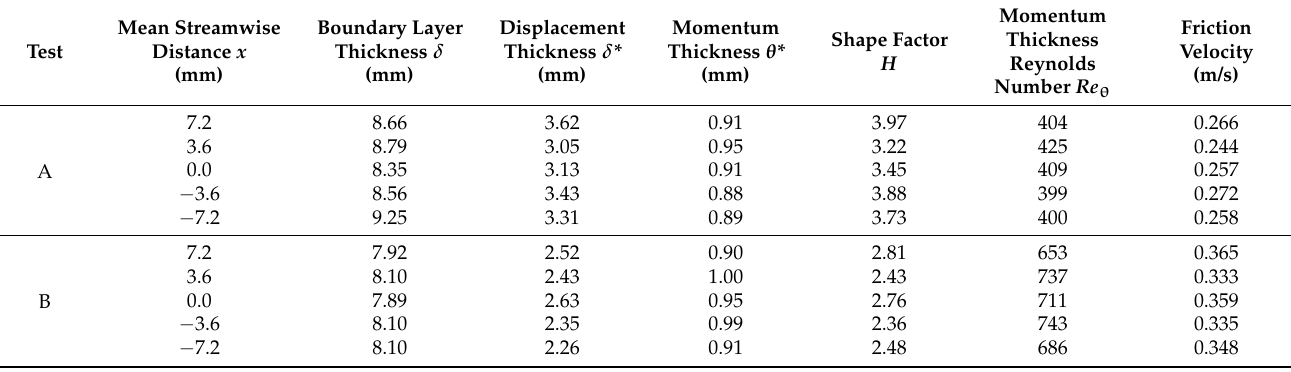
Table 5. Boundary layer and friction parameters for flow over porous media. Here, the results show spanwise variation for flow between columns 8 and 9.